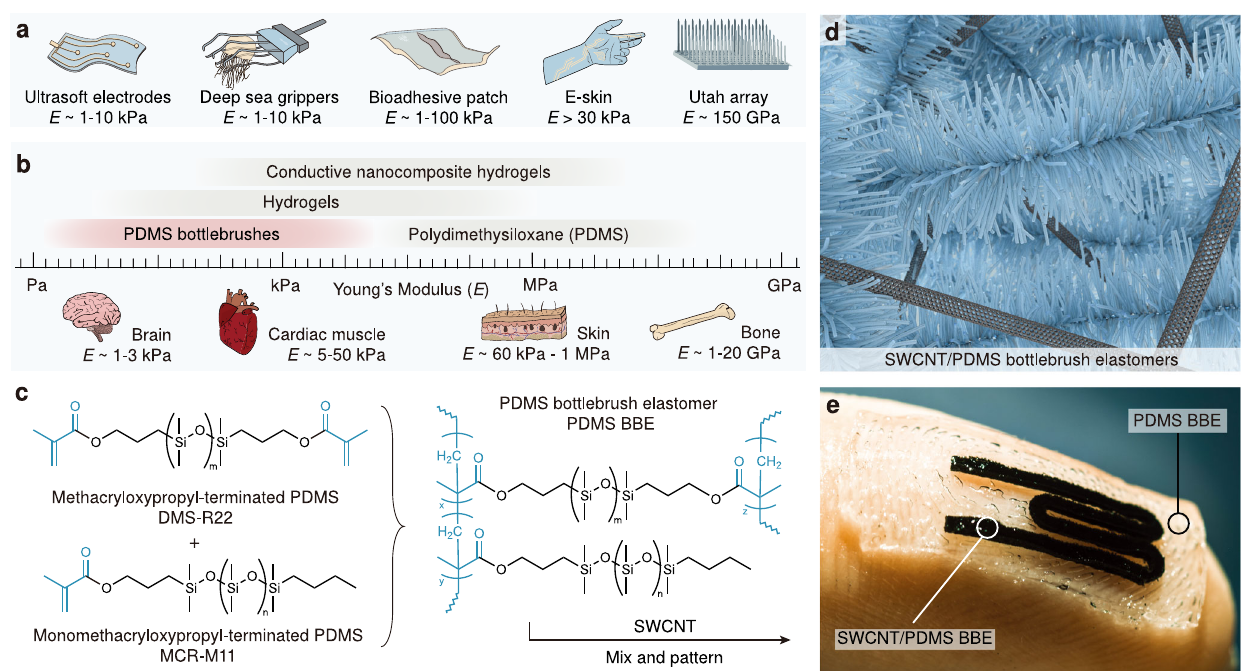
Fig. 1 | Design of ultrasoft and conductive BBE composites. a Different appli- cations require soft and/or stretchable materials with different levels of Young ’ s modulus ( E ).In comparison, conventionalelectronic materials(silicon and metals) applied on rigid electronics (e.g., the Utah array) have a much higher E than intrinsically stretchable materials. b The approximate Young ’ s modulus range of different biological tissues and commonly used intrinsically stretchable